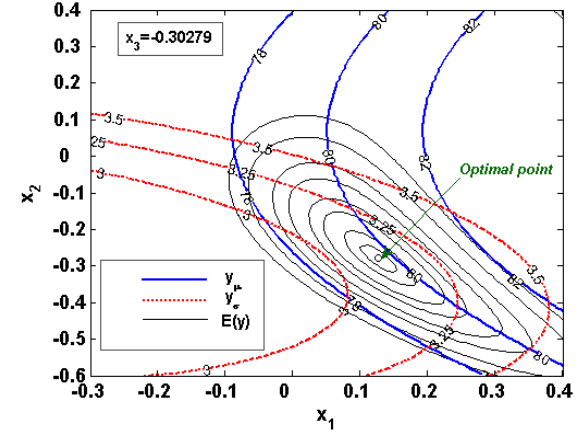
Figure 12. Contour plot for the estimated mean and standard deviation for Example